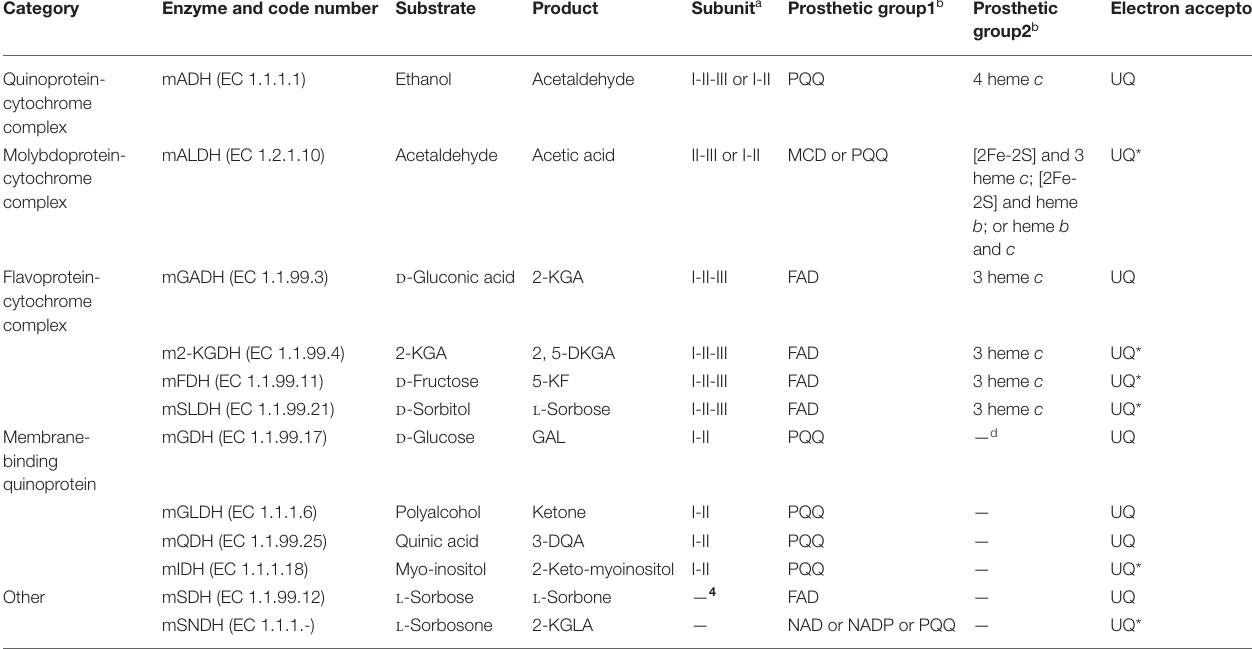
TABLE 2 | The membrane-binding dehydrogenases in acetic acid bacteria based on their coenzyme differences. Category Enzyme and code number Substrate